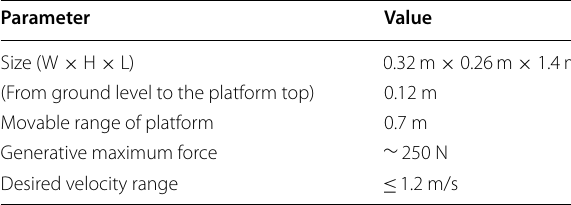
Table 1 Specifications of the ERIK prototype